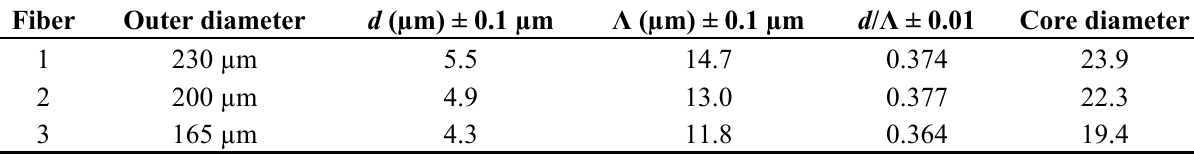
Table 1. Geometrical parameters of the